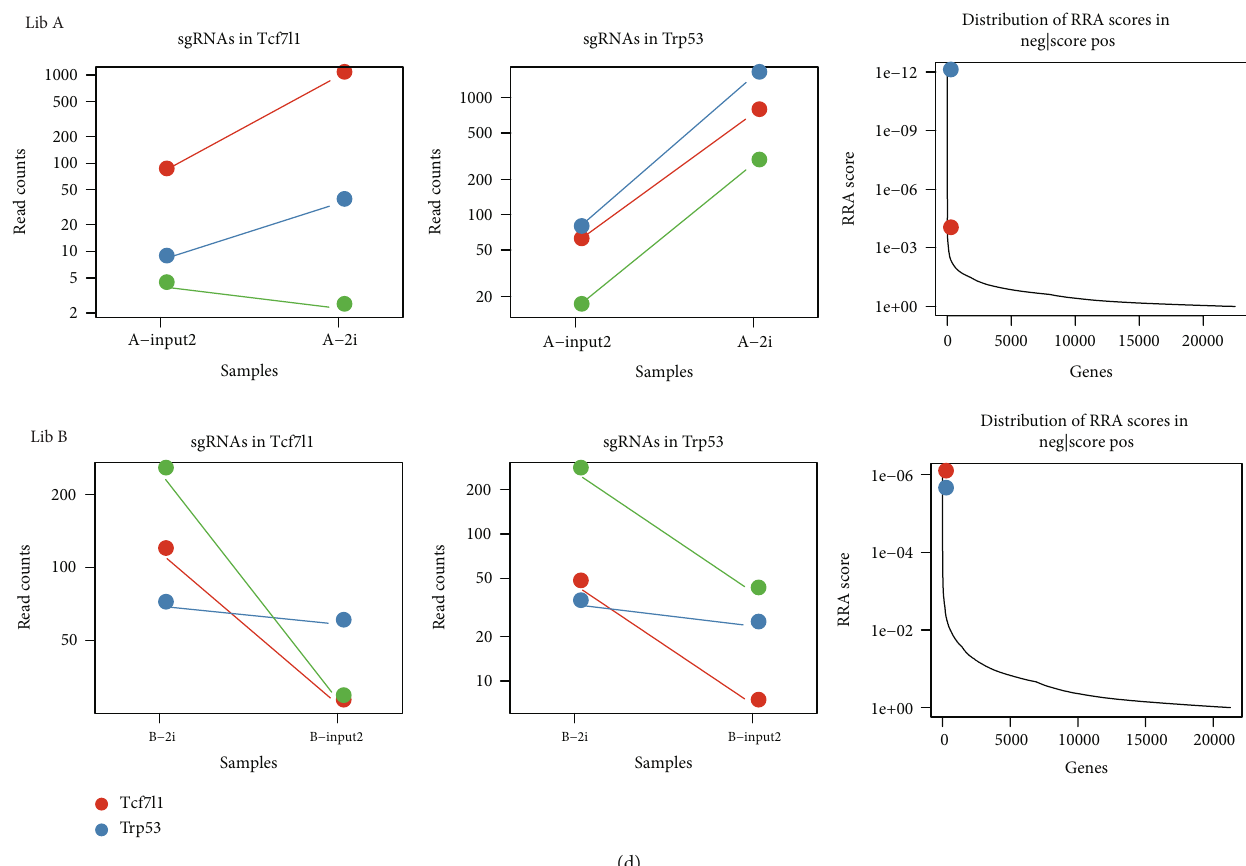
Figure 3: Screening data GO analysis. (a, b) Comparison of input 1 with input 2 for genome-scale negative selection screening. The most signi fi cantly depleted genes in mESCs transfected with both GeCKO (v2.0) library A and B. (c, d) GeCKO screen in mESCs reveals genes whose loss confers commitment resistance. The most signi fi cantly enriched genes including two positive controls Trp53 and Tcf7l1 (ranking fi rst and second), as well as another 70 candidate genes (A/B-2i/LIF: E-group with library